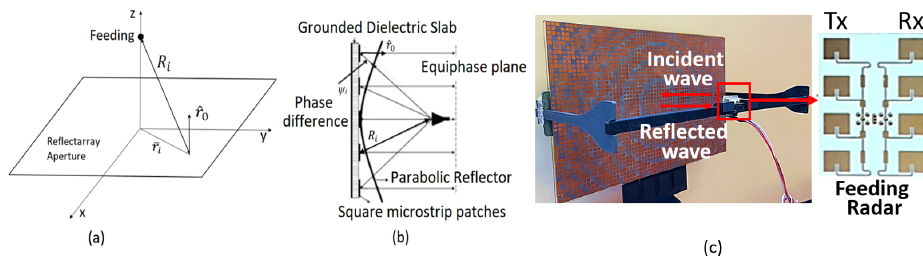
Figure 1. The reflectarray antenna geometry showing ( a ) a 3D view of a feeder in the focus point of the reflectarray aperture, ( b ) a cross-sectional view showing the phase ( ψ i ) required to be adjusted for a constructive phase in direction and ( c ) the final reflectarray geometry with the feeder placed 10 cm